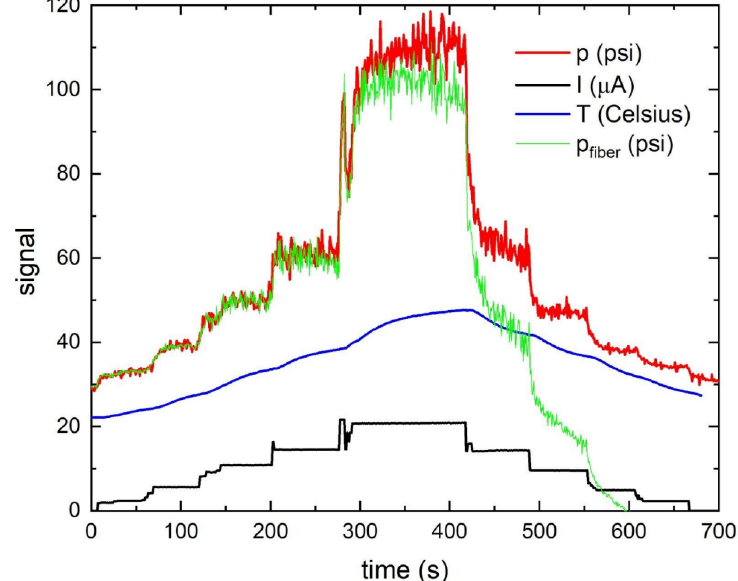
Figure 6. Results from the first isotope production experiment illustrating the results of an irradiation of naturally abundant purified water. The black curve shows the proton beam current. The red curve represents the readings of the reference pressure transducer attached to the target body. The green curve shows the readings of the Fibos FBG-based pressure transducer. The blue curve illustrates the readings of the Fibos FBG-based temperature probe in contact with the target body wall. The unit of the individual signals is listed in the